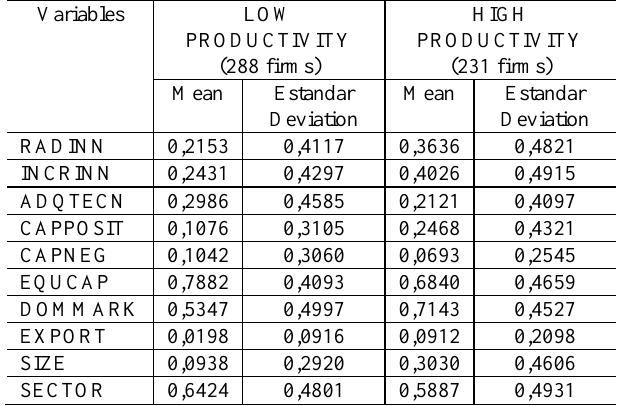
Table 1: Descriptive statistics for productivity